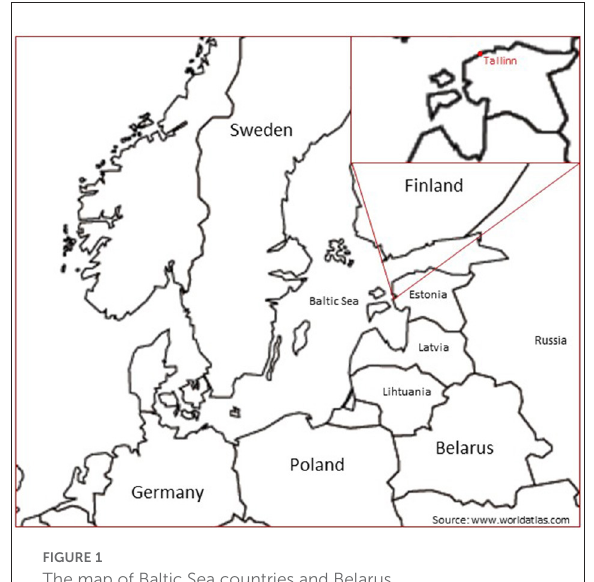
FIGURE1 The map of Baltic Sea countries and